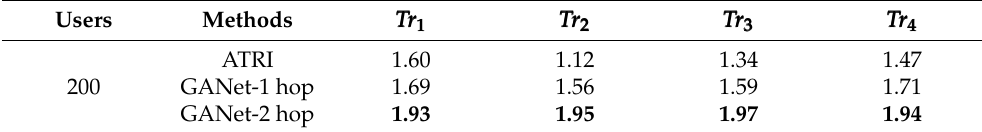
Table 2. Comparing fitness obtained with 156 UAVs and 200 users on training scenarios.